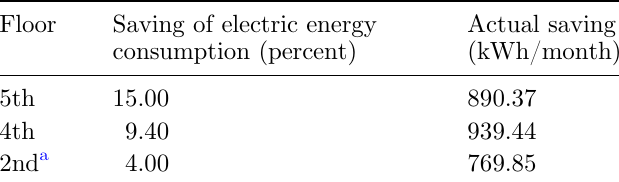
Fig. 7. The saving in electrical energy when applying Case B for the 5th, 4th and 2nd fl oors. Table 2. Results in energy saving of Case B.